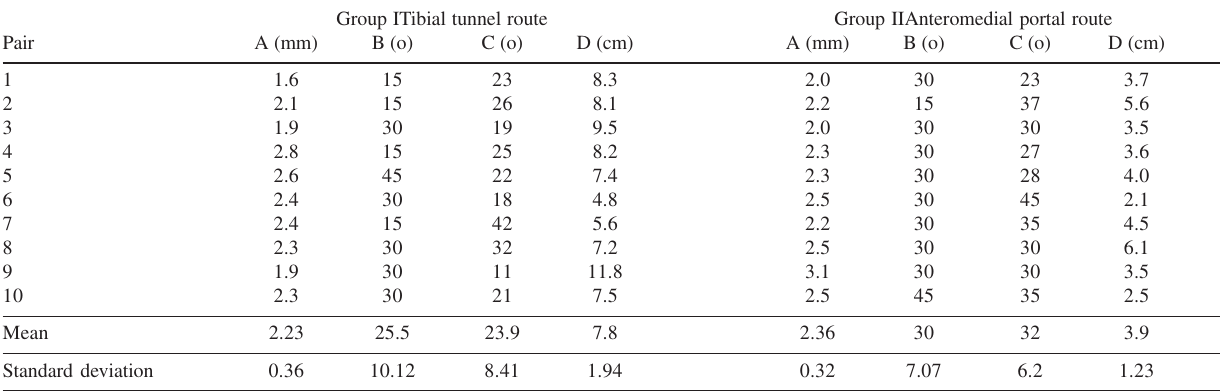
Table 1 - Results obtained. A= thickness of the posterior wall of the femoral tunnel, measured using pachymeter, in millimeters; B= anterior view of the positioning of the tunnel entrance in the intercondyle notch, in degrees; C= inclination of the femoral tunnel in degrees, in relation to the long axis of the femoral diaphysis in the sagittal plane; D= distance in centimeters between the guide wire exit in the anterolateral cortex of the femur and the lateral epicondyle. Group ITibial tunnel route Group IIAnteromedial portal route Pair